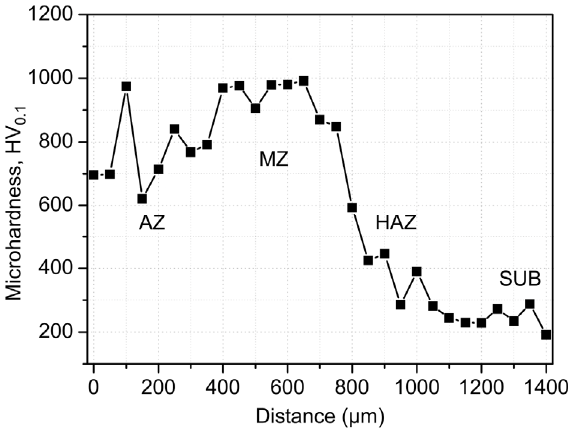
Figure 15. Microhardness profile of HVHSS graded coating on iron substrate as a function of depth [63].